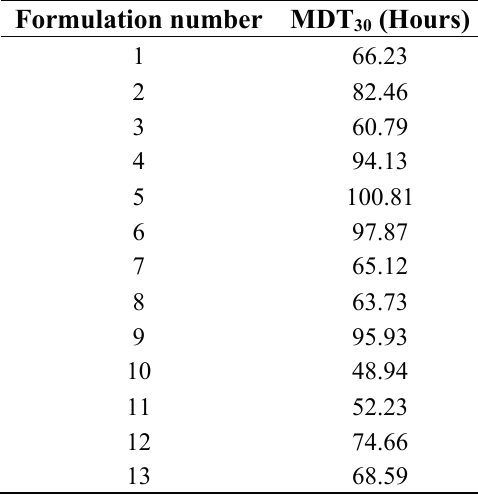
Figure 10. In vitro CPZ release profiles from PCL based nanocapsules as per experimental design, (SD ≤ 0.04 in all cases, N = 3). Table 2. MDT 30 values achieved for each formulation of the experimental